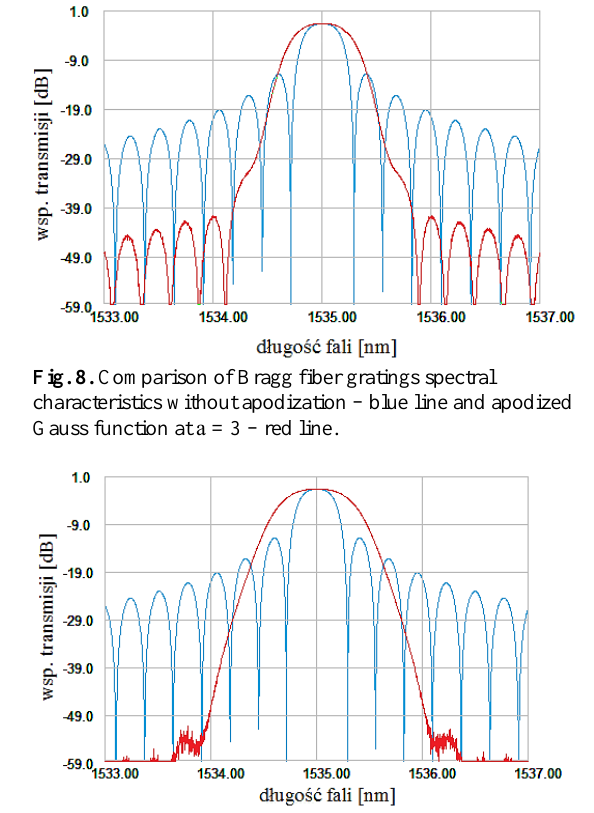
Fig. 9. Comparison of Bragg fiber gratings spectral characteristics without apodization – blue line and apodized Gauss function at а = 5 – red line.